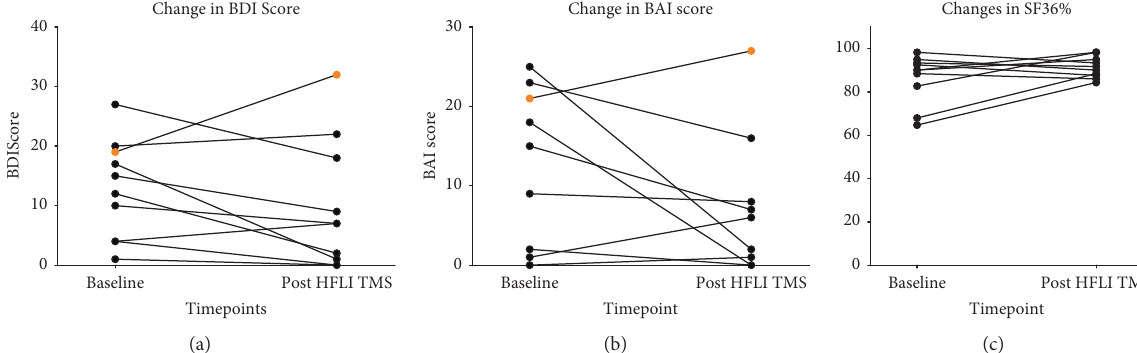
Figure 2: Change in several scores before and after HFLI TMS. Changes in (a) BDI score, (b) BAI score, and (c) SF36% before and after HFLI TMS; no statistical significance was achieved in any of the scores. The orange dot represents subject 7 (see text for more information). BDI, Beck Depression Index; BAI, Beck Anxiety Index; SF36%, percentage of Short Form Health Survey; HFLI TMS, High Frequency and Low Intensity Transcranial Magnetic